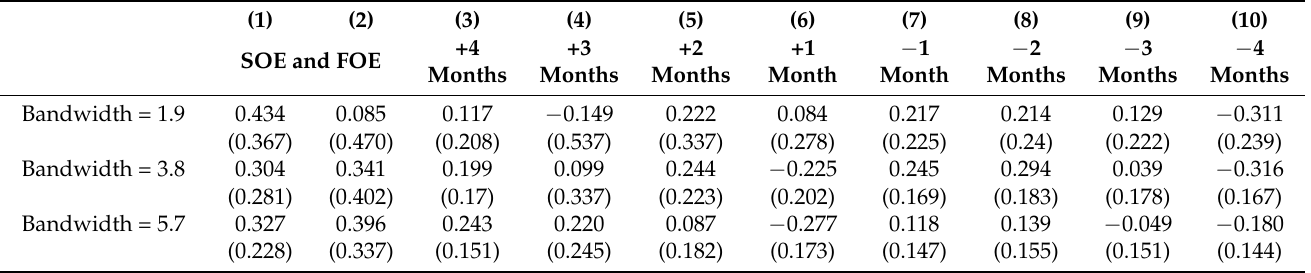
Table 5. Identification Checks: Placebo test on SOEs, FOEs and the cut-off